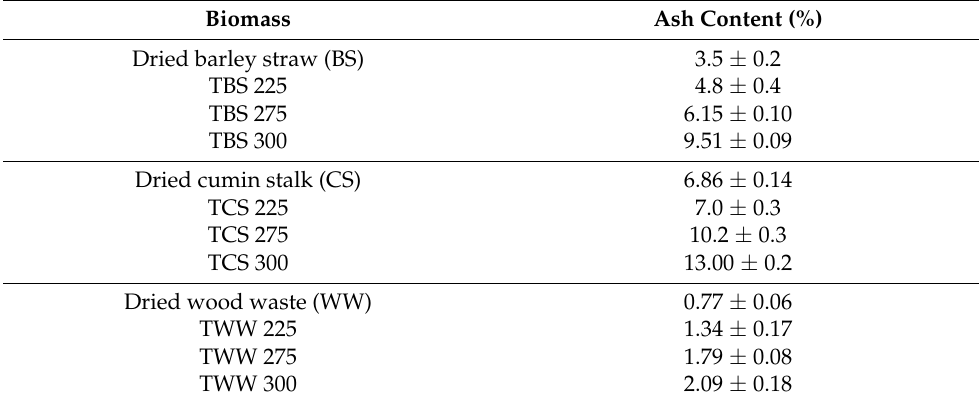
Table 6. Ash content of raw biomass and biomass torrefied at different temperatures with 60 min of residence